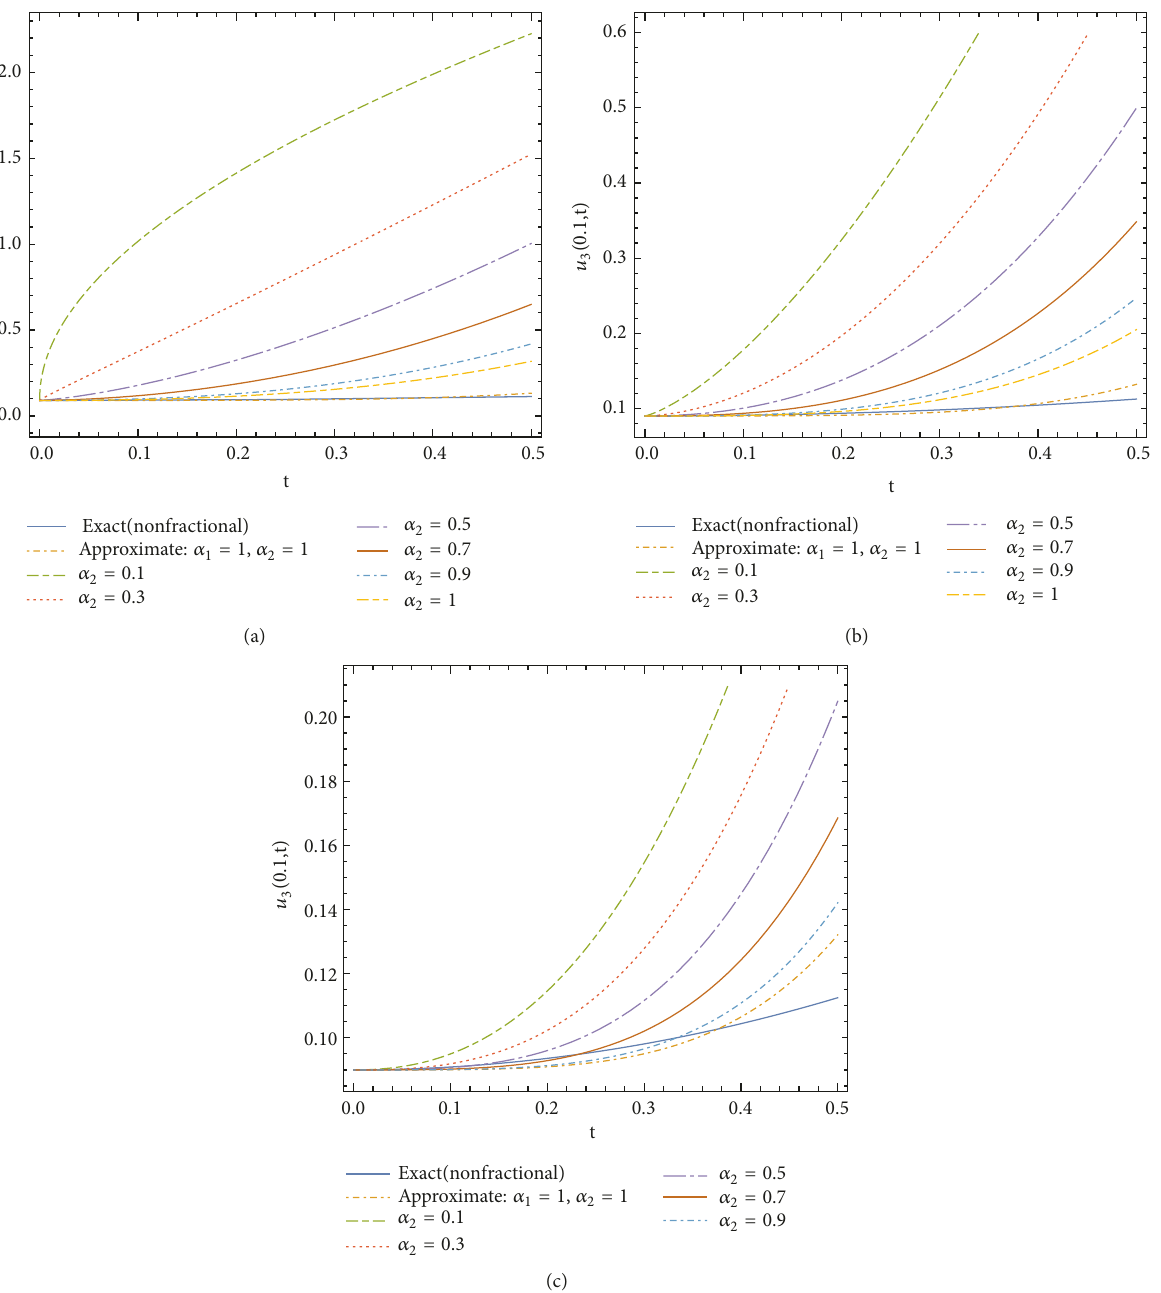
Figure 5: The 3-term FRDTM solutions 𝑢 3 . (a) constant 𝛼 1 = 0.1 and different values of 𝛼 2 , (b) constant 𝛼 1 = 0.5 and different values of 𝛼 2 , and (c) constant 𝛼 1 = 1 and different values of 𝛼 2 ; 𝑡 ∈ [0,0.5] ; and 𝑥 = 0.1